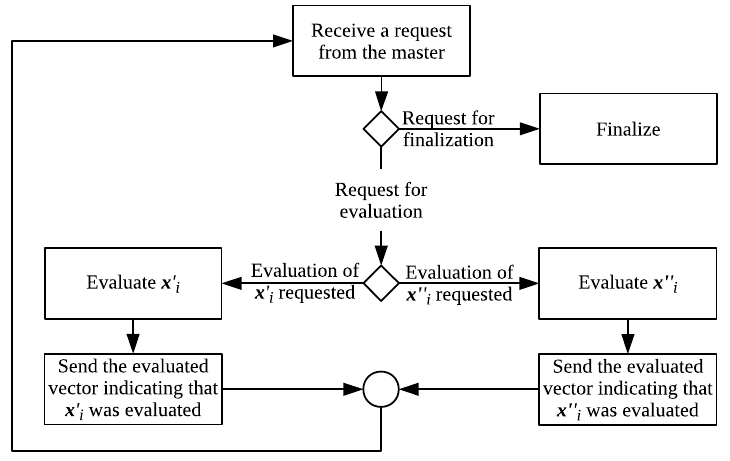
Figure 4. Scheme of ParMOSS algorithm for the i -th slave processing unit, where i = 1 , 2 ,...,p .